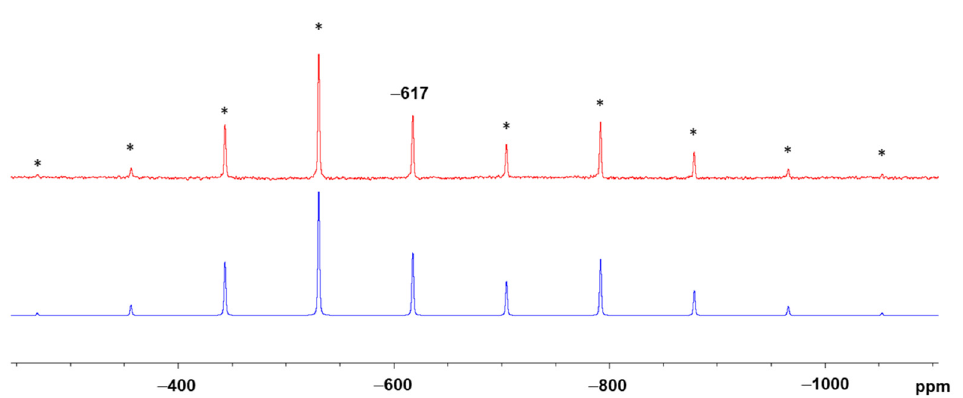
Figure 5 . 29 Si MAS NMR spectrum of PhSn(pyO) 3 recorded at a spinning frequency of 13 kHz (top, red trace) and simulated spectrum using the CSA tensor data derived from the experimental spectrum (bottom, blue trace). The asterisked (*) peaks are spinning sidebands. CSA tensor data: δ iso − 617.4 ppm, δ 11 − 393.5 ppm, δ 22 − 502.2 ppm, δ 33 − 956.5 ppm, Ω 563 ppm, κ 0.61.